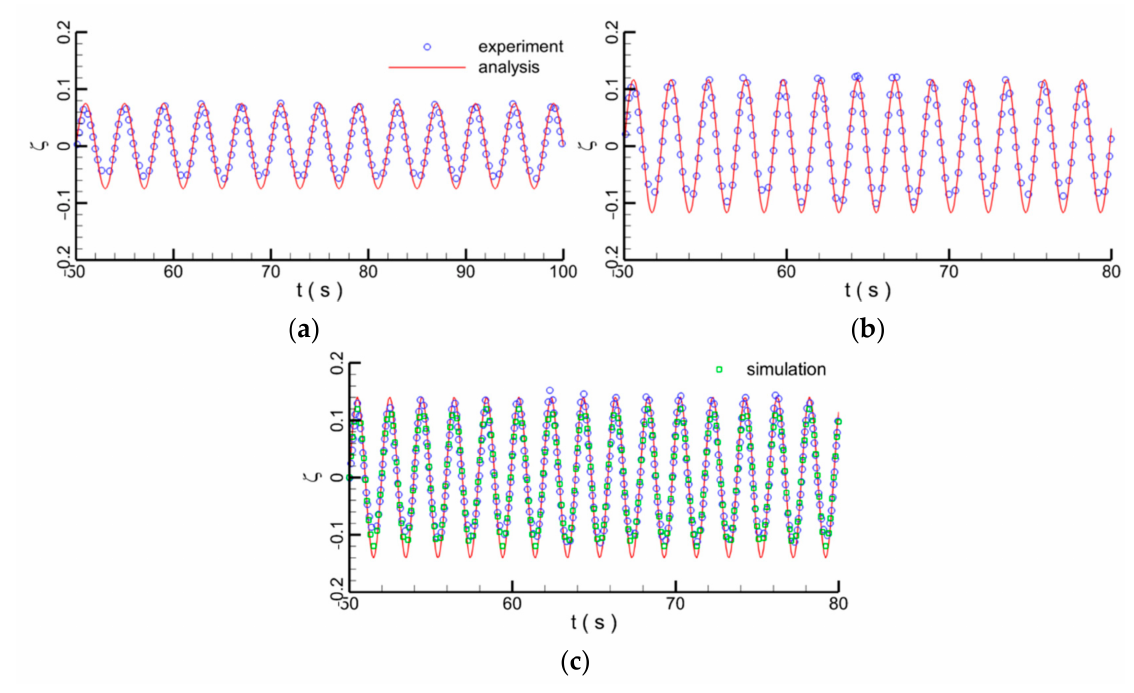
Figure 5. Temporal evolution for the regular waves: ( a ) case 1; ( b ) case 3; ( c ) case 5.